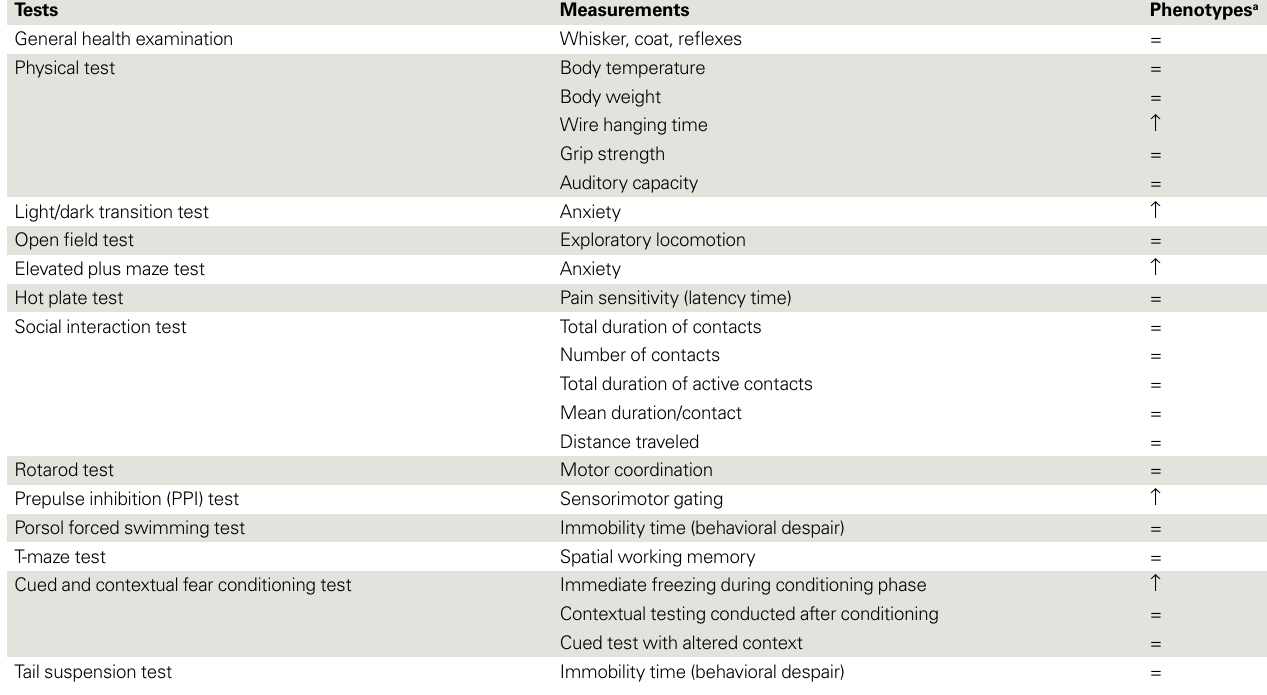
Table 1 | Behavioral phenotypes of kf-1 –/– mice compared to the behavioral phenotypes of kf-1 +/+